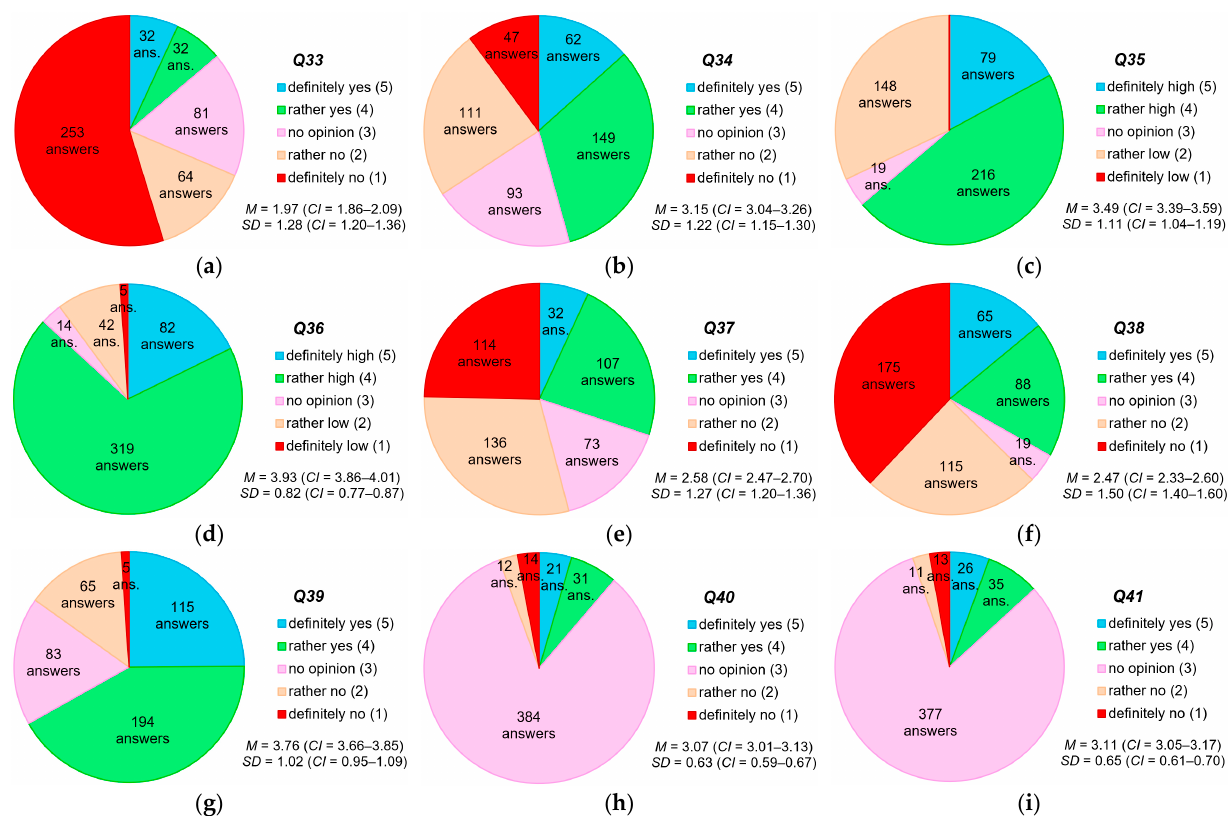
Figure 14. Assessment of the possibility of implementing shower heat exchangers in residential buildings ( M —average, SD —standard deviation, CI —confidence interval; questions numbers ( Q ) according to the Appendix A): ( a ) question Q 33; ( b ) question Q 34; ( c ) question Q 35; ( d ) question Q 36; ( e ) question Q 37; ( f ) question Q 38; ( g ) question Q 39; ( h ) question Q 40; (i) question Q 41.